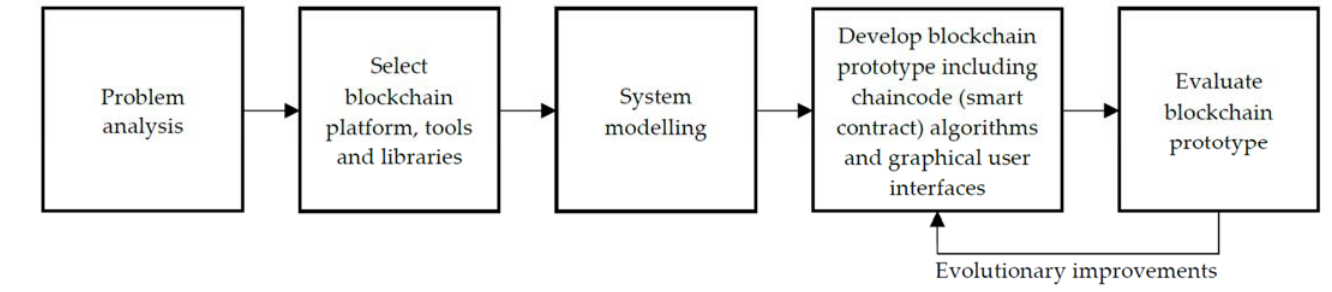
Figure 3. Research method to develop the blockchain-based software prototype.